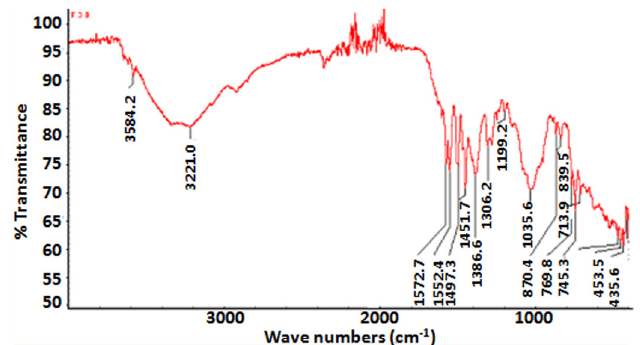
FIGURE 4 – FTIR spectrum of formulation blend containing Prunus domestica